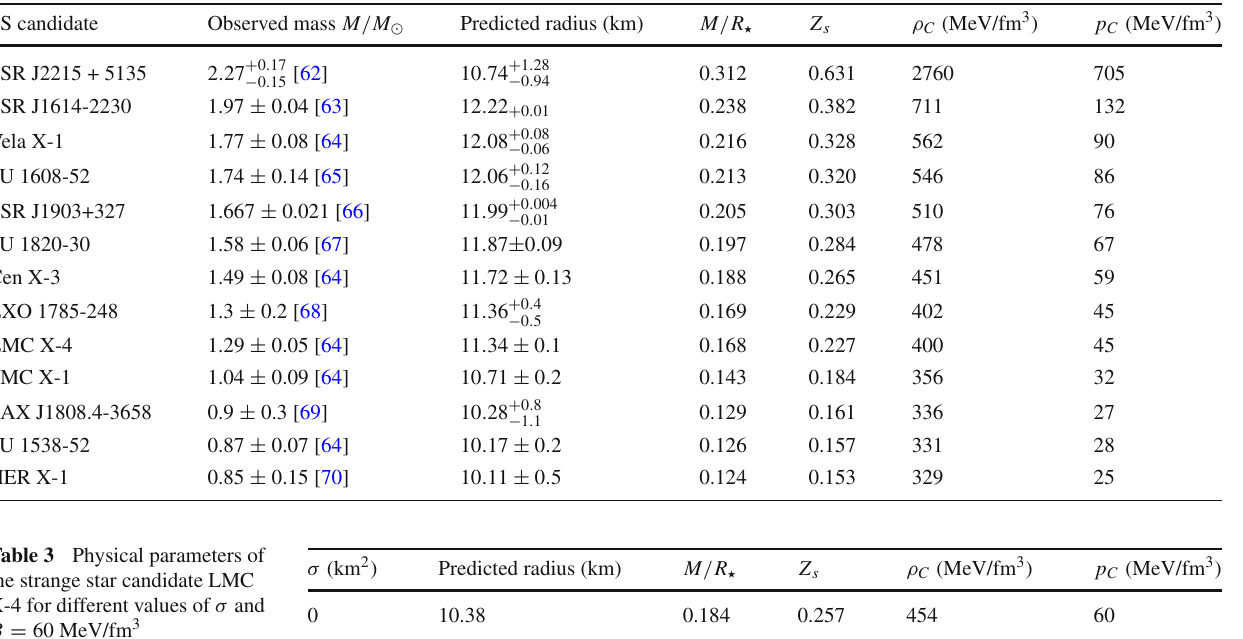
Table 2 Physical parameters of observed strange star candidates derived using σ = 30 km 2 and B = 60 MeV/fm 3 SS candidate